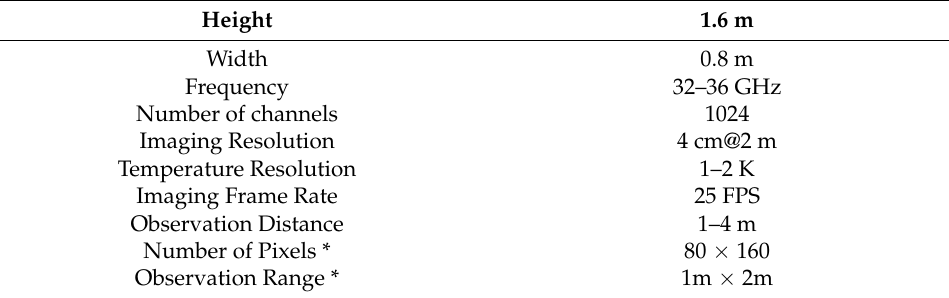
Figure 8. BHU-1024 including the main components ( a ) and experimental passage ( b ). Table 1. Specification of BHU-1024.